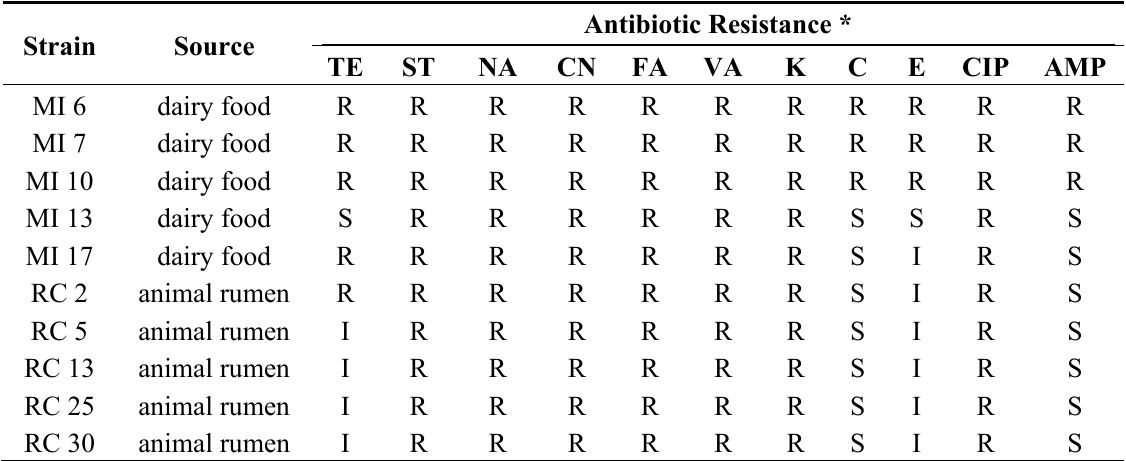
Table 4. Strain antibiotic resistance profile against various antibiotics tested.